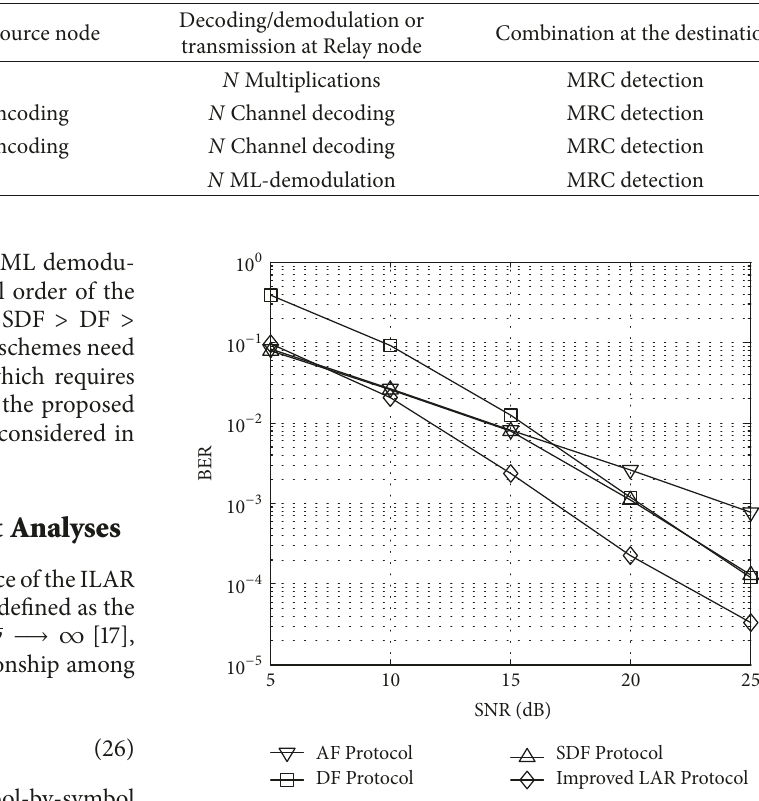
Table 1: Complexity of the proposed ILAR scheme and the contrast schemes.